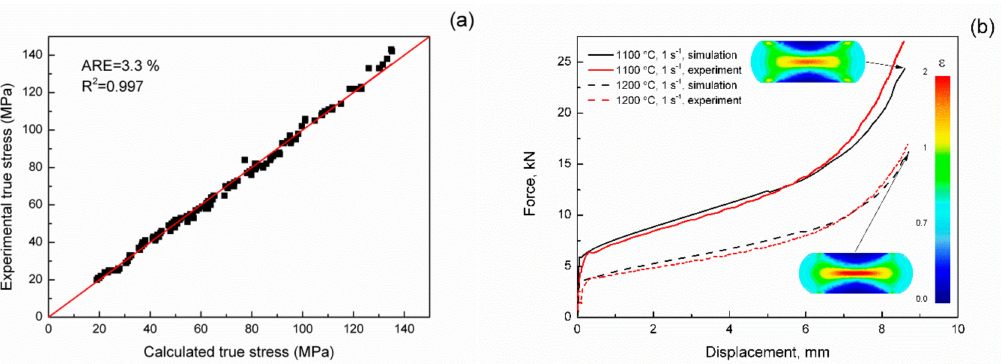
Figure 6. The comparison between the calculated and experimental values of flow stress ( a ) and calculated and FEM simulated force vs. displacement curves ( b ).